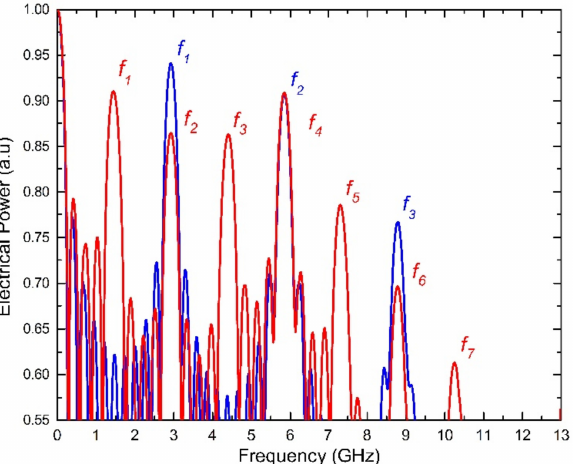
Figure 8. Simulated frequency response of the MPF corresponding to the use of δλ = 0.82 nm (blue curve), and δλ = 1.61 nm (red curve).